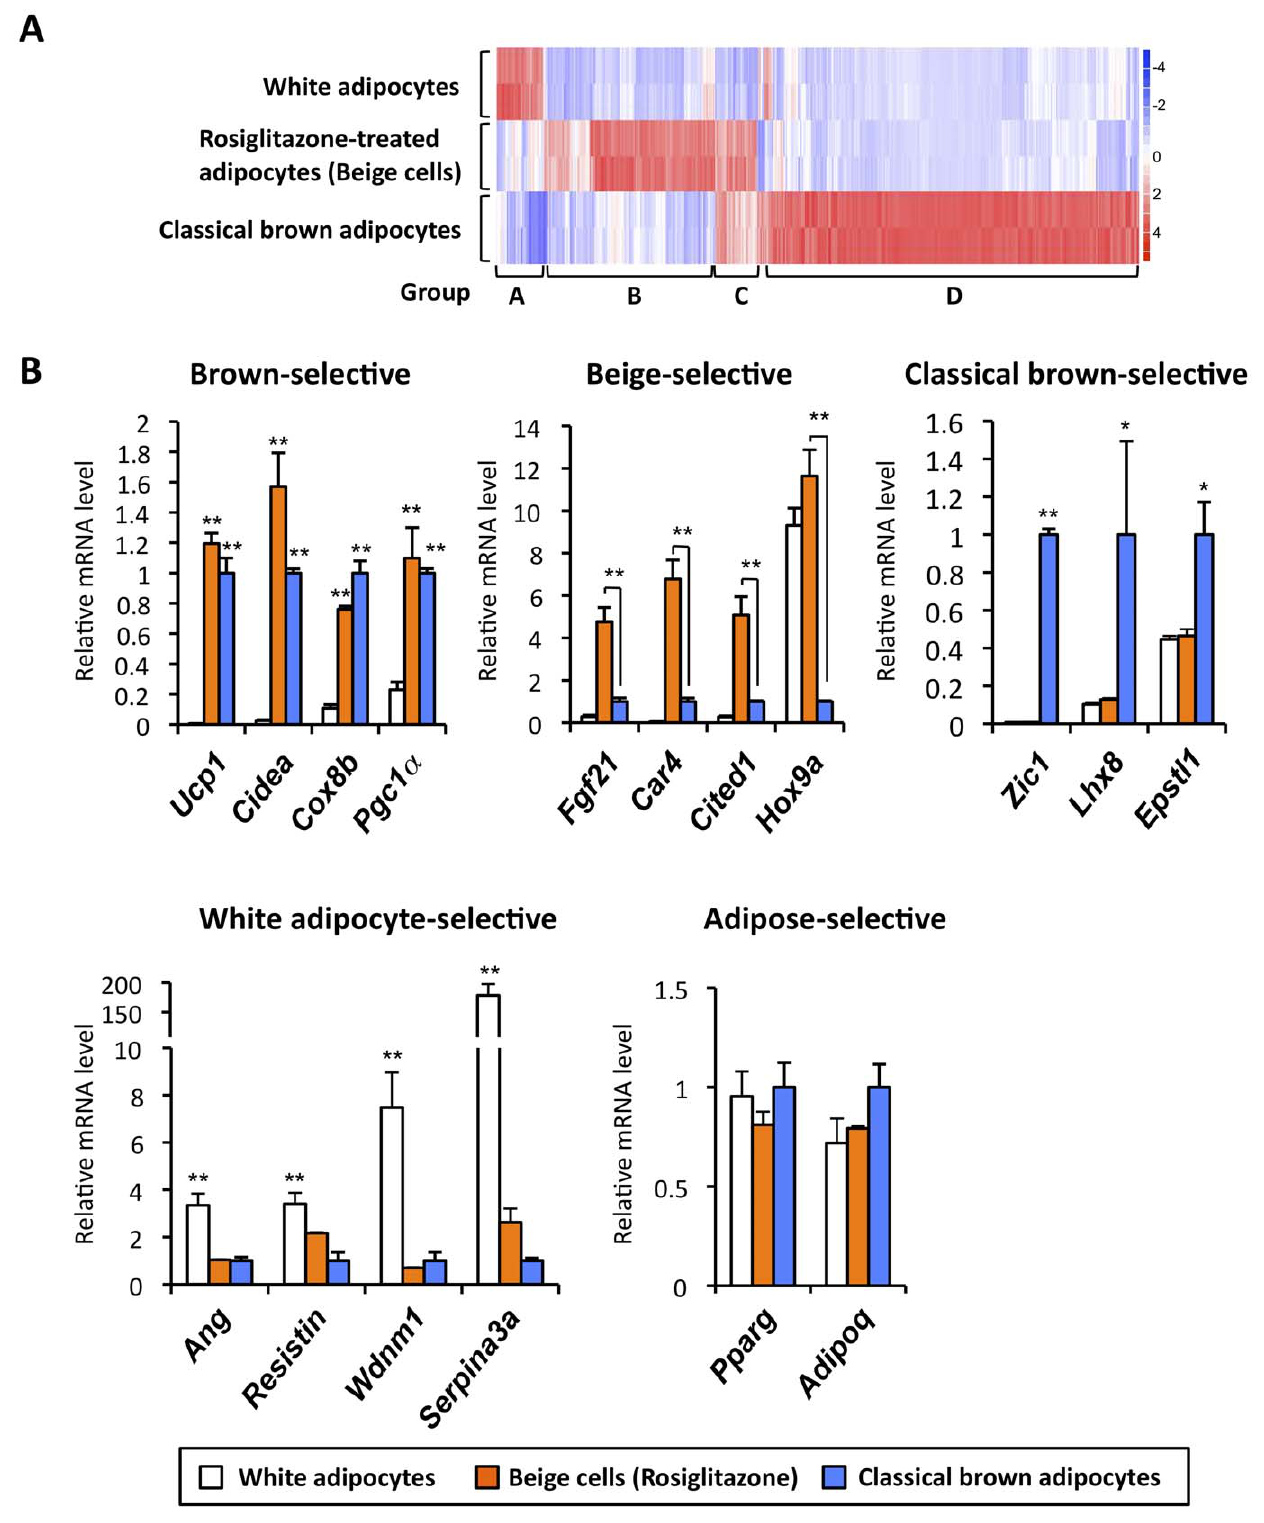
Figure 1. Distinct molecular signatures in Myf-5 derived classical brown adipocytes and non- Myf-5 derived beige cells. ( A ) Microarray analysis was performed in fully differentiated brown adipocytes from interscapular BAT (classical brown adipocytes), white adipocytes isolated from inguinal WAT and rosiglitazone-treated adipocytes (beige cells). The color scale shows the fold changes in mRNA expression levels of the genes in blue (down-regulation)-white-red (up-regulation) scheme. ( B ) mRNA levels for the indicated genes were analyzed by qRT-PCR. Relative expression levels in the brown adipocyte were set as 1.0. * P , 0.05, ** P , 0.01. Data are expressed as means 6 SD.